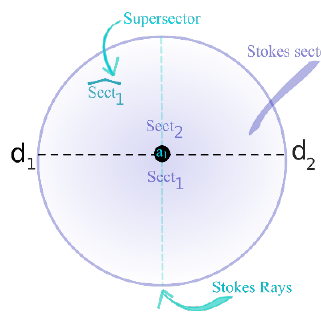
Figure 3 . Stokes rays, and Stokes Sectors and Super